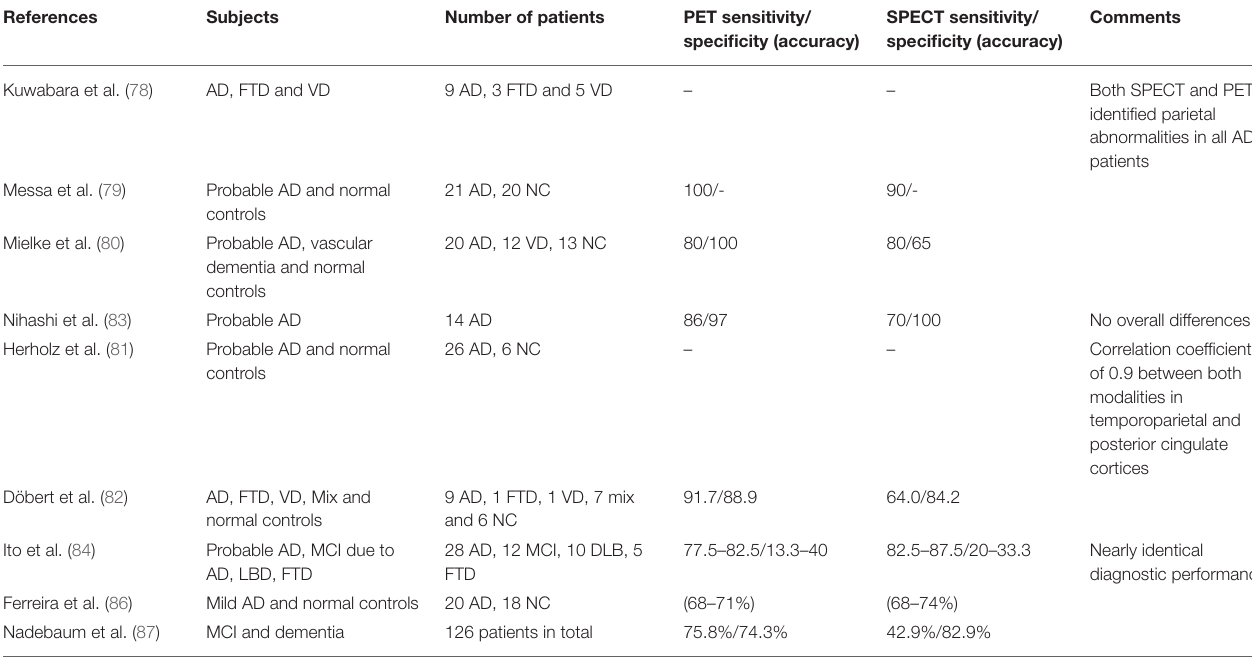
TABLE 1 | Summary of studies directly comparing SPECT and PET performance in the same group of